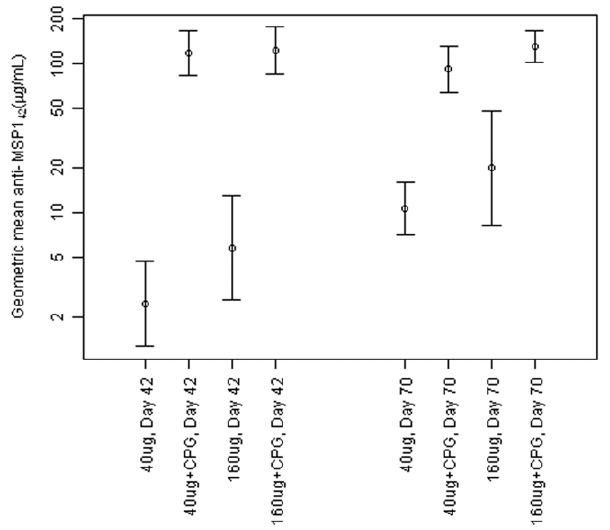
Figure 3. Geometric mean of average of FVO and 3D7 anti- MSP1 42 (ug/mL) over time. Includes only subjects with samples at all time points (40 ug: n = 12, 40 ug + CPG: n = 12, 160 ug: n = 10, 160 ug + CPG: n=8).